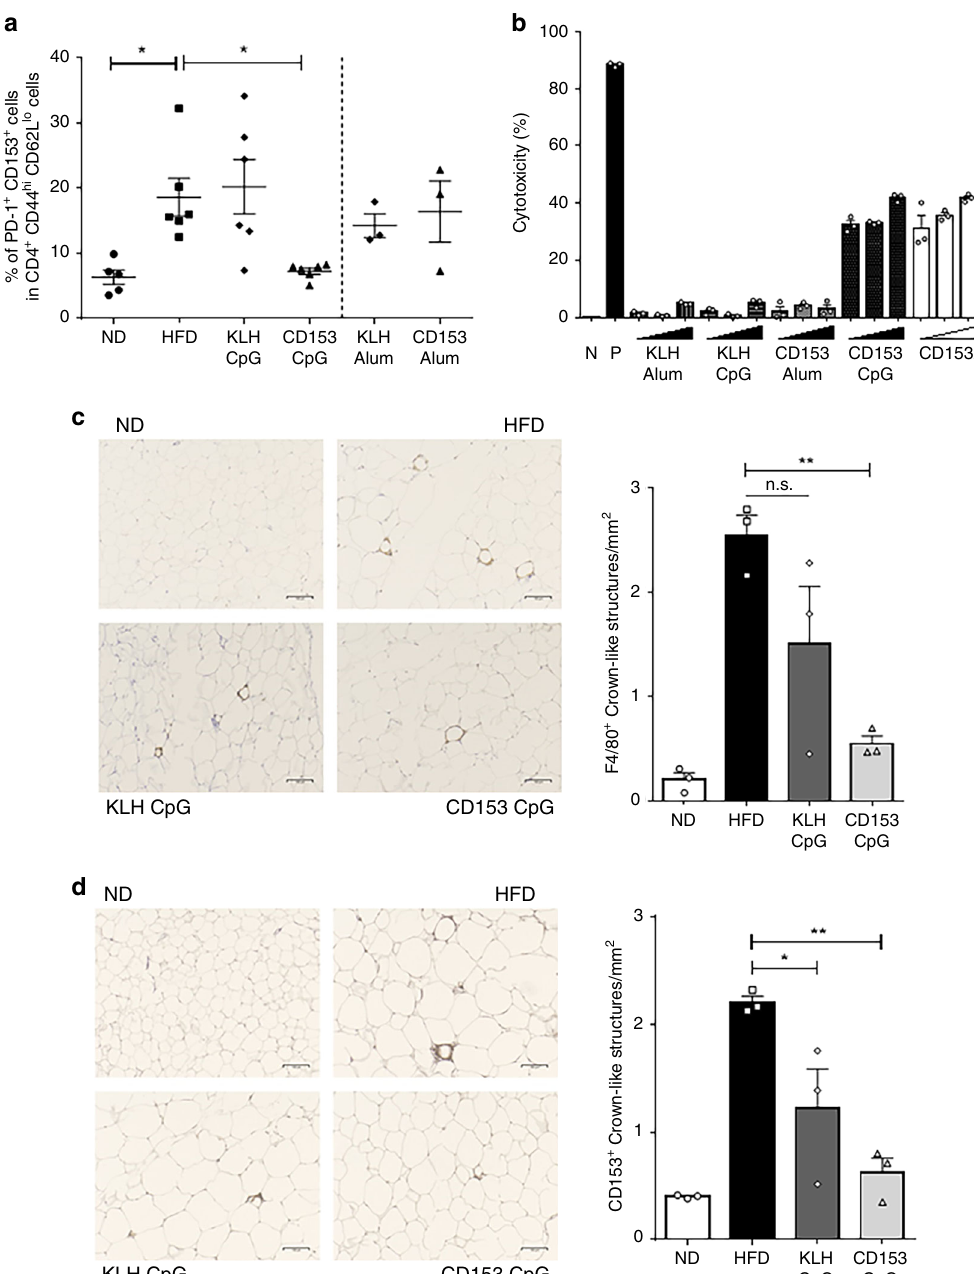
Fig. 4 Effect of the CD153-CpG vaccine on CD153 + senescent T cells induced by HFD loading. a The proportions of senescent T cells induced by HFD loading in the VAT of mice immunized with the Alum-conjugated vaccine or the CpG-conjugated vaccine. Senescent T cells were de fi ned as PD-1 + CD153 + cells in CD4 + , CD44 hi , CD62L lo cells. Alum-conjugated vaccine group, n = 3 in each group; CpG-conjugated vaccine group, n = 6 in each group; ND control group, n = 5; HFD control group, n = 6. b The CDC activity of the CD153 vaccine-induced antibody was assessed ( n = 3 each sample) using 2 × 10 4 LPS- stimulated RAW 264.7 cells. The vaccine-induced IgG antibodies used were puri fi ed from the sera of HFD-loaded mice at the age of 22 – 25 weeks immunized with the CD153-Alum vaccine, CD153-CpG vaccine, KLH-Alum vaccine or KLH-CpG vaccine. N, no stimulation with antibody; P, 100 µ g/ml anti-mouse MHC class I antibody (H-2Kd/H-2Dd); closed right triangle, the concentrations of puri fi ed IgG antibodies; opened right triangle, the concentrations of anti-mouse CD153 antibody (10, 30, 100 µ g/ml, respectively). c , d VAT were collected from the four groups of mice (ND control group, HFD control group, KLH-CpG vaccine group, and CD153-CpG vaccine group; n = 3 in each group) according to the time course of HFD loading and injection of vaccines. c Quanti fi cation of macrophages in the crown-like structures among the four groups. HFD vs. KLH-CpG, p = 0.11; HFD vs. CD153-CpG, p = 0.0041; KLH-CpG vs. CD153-CpG, p = 0.15. 40 – 50 fi elds per sample, F4/80 (brown); scale bars: 100 µ m. d Quanti fi cation of CD153-positive cells in the crown-like structures among the four groups. HFD vs. KLH-CpG, p = 0.024; HFD vs. CD153-CpG, p = 0.0015; KLH-CpG vs. CD153-CpG, p = 0.20. 40 – 50 fi elds per sample, CD153 (brown); scale bars: 100 µ m. All the data are expressed as the mean ± SEM. Statistical evaluation was performed by two- sided; unpaired two-tailed t-test, KLH-Alum vs. CD153-Alum ( a ); Bonferroni correction, ND vs. HFD ( a ), HFD vs. KLH-CpG vs. CD153-CpG ( a , c , d ); * p < 0.05; ** p < 0.01; n.s. not signi fi